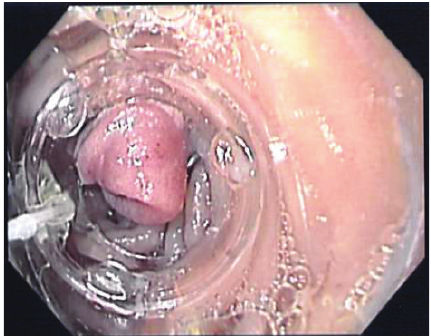
Figure 1: Spot draining from the internal fistula orifice at the dome of the blind limb of Billroth II after injecting it percutaneously.